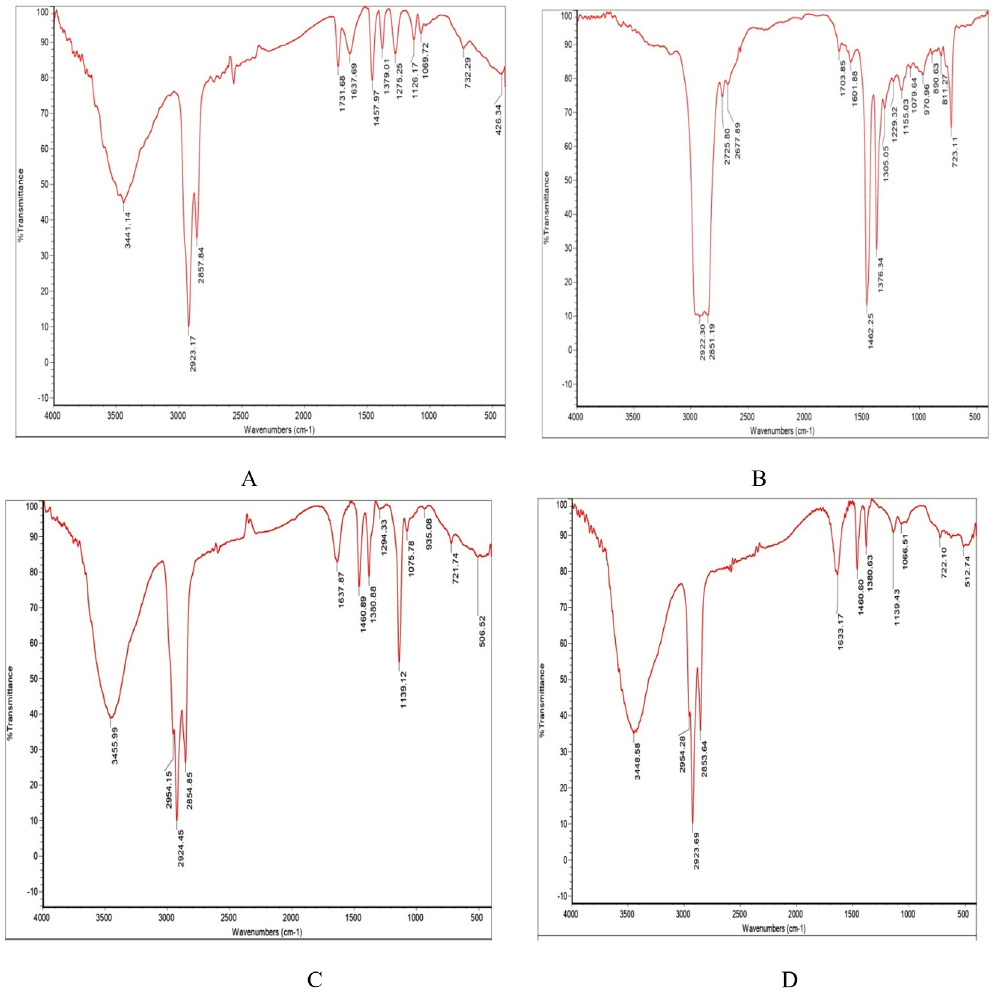
Fig. 4 (A-D). FT/IR spectra of biodegraded used engine oil by individual isolates. A: Enterobacter aerogenes , B: Raoultella sp, C: Bacillus megaterium , D: Bacillus